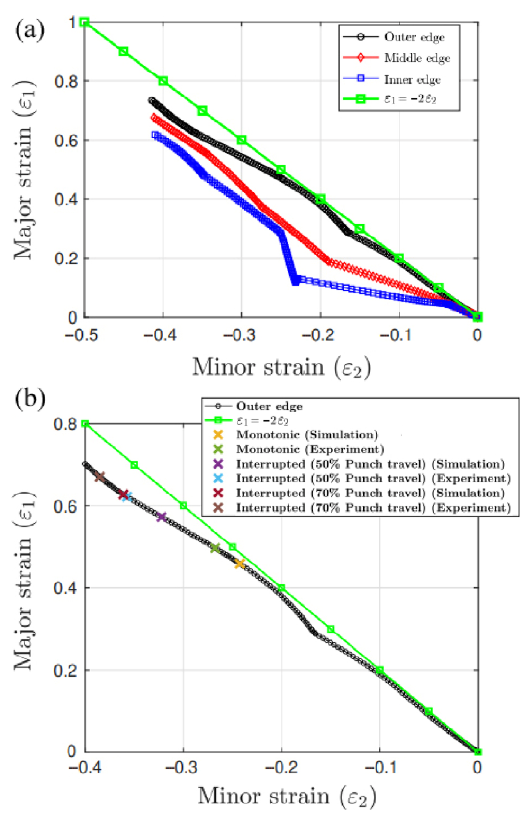
Fig. 13 (a) Strain path evolution during HET and (b) major ( and minor strains (  ) at fracture in monotonic and interrupted 2 loading conditions in the outer edge.